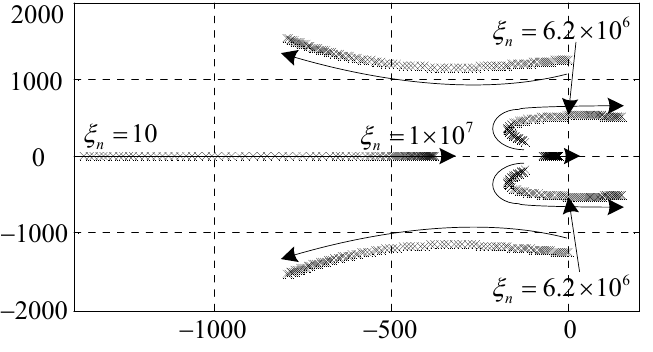
Figure 5. Root locus of the clean synchronous i x control subsystem